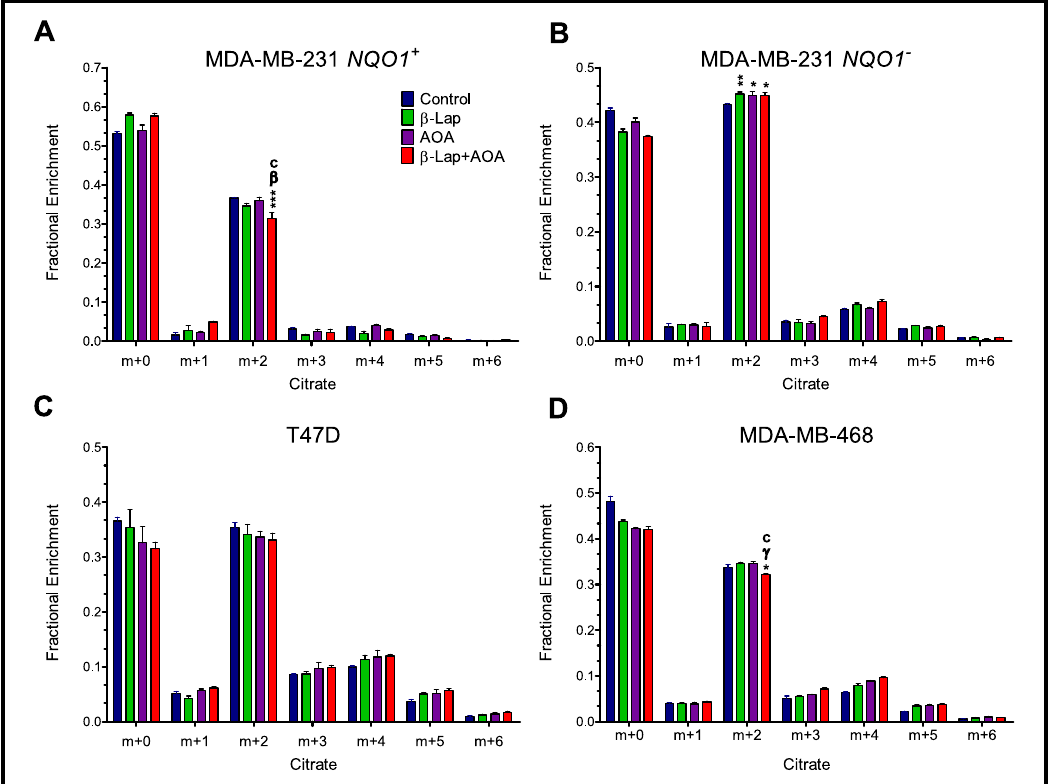
Figure 6. Citrate isotopologue distribution of breast cancer cells treated with β -lap and AOA. MDA- MB-231 NQO1 + (Panel ( A )) and MDA-MB-231 NQO1 − (Panel ( B )) cells show that AOA enhances β -lap drug action in downregulating the TCA cycle. T47D (Panel ( C )) cells showed no significant differences in isotopologue fractional enrichments across treatments. MDA-MB-468 (Panel ( D )) cells showed a significant decrease in citrate m+2 labeling in combinatorial treatment compared to all other groups. (Note: n = 3, biological replicate data are represented as mean ± SEM. Statistical significance was determined by ANOVA and student’s t -test post hoc analysis and is presented as: (*) if p ≤